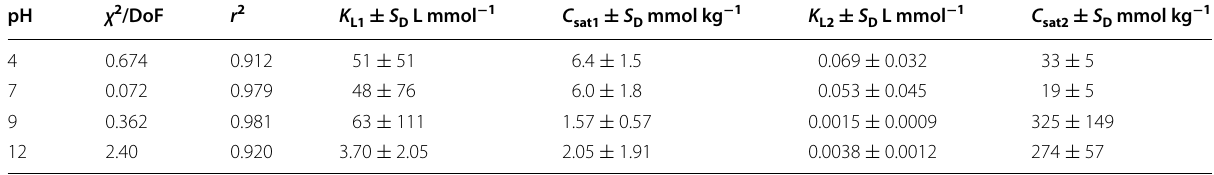
X 2 /DoF, probability distribution normalized to the number of data points; r 2 , determination coefficient; K L , Langmuir affinity constant (1: “high”, 2: “low” affinity sites); C sat , saturation concentration; S D , standard deviation